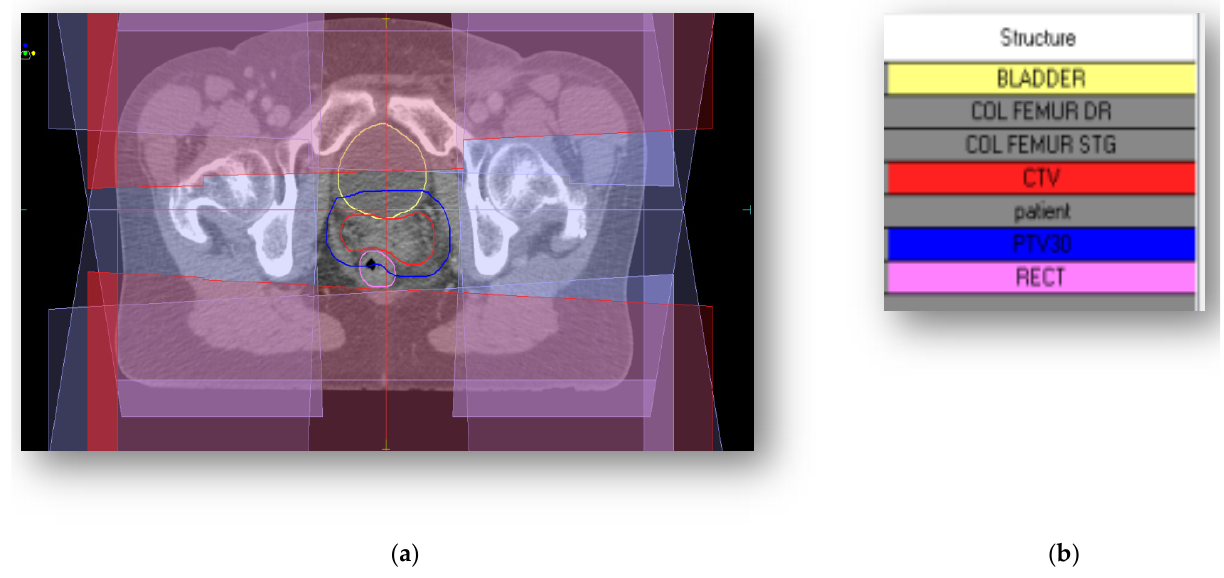
Figure 3. Aspects of radiotherapy plan highlighting the structures: ( a ) the description of field distribution; ( b ) the description of structures defined in planned treatment.